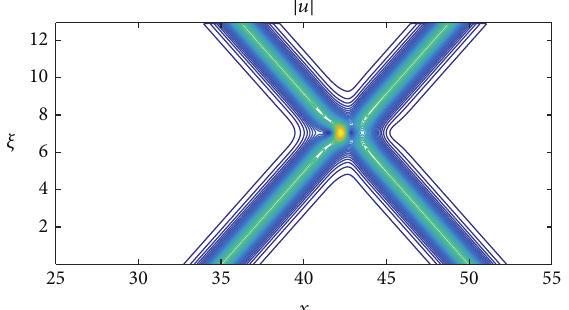
Figure 13: Contour plot of the collision of solitons in Figure 11.